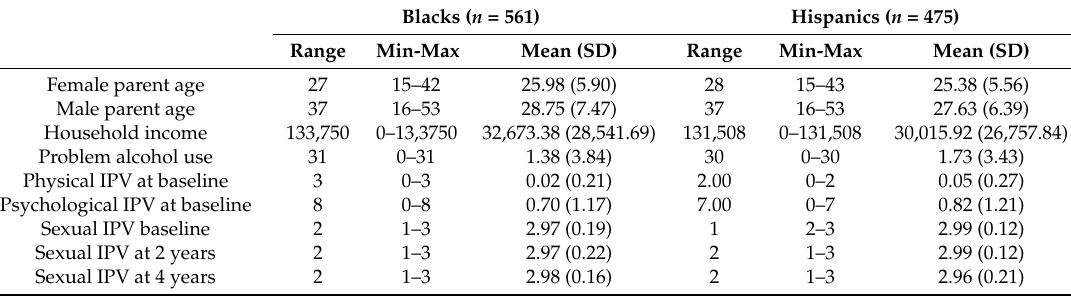
Table 3. Descriptive statistics of male partners’ socio-demographics and mental